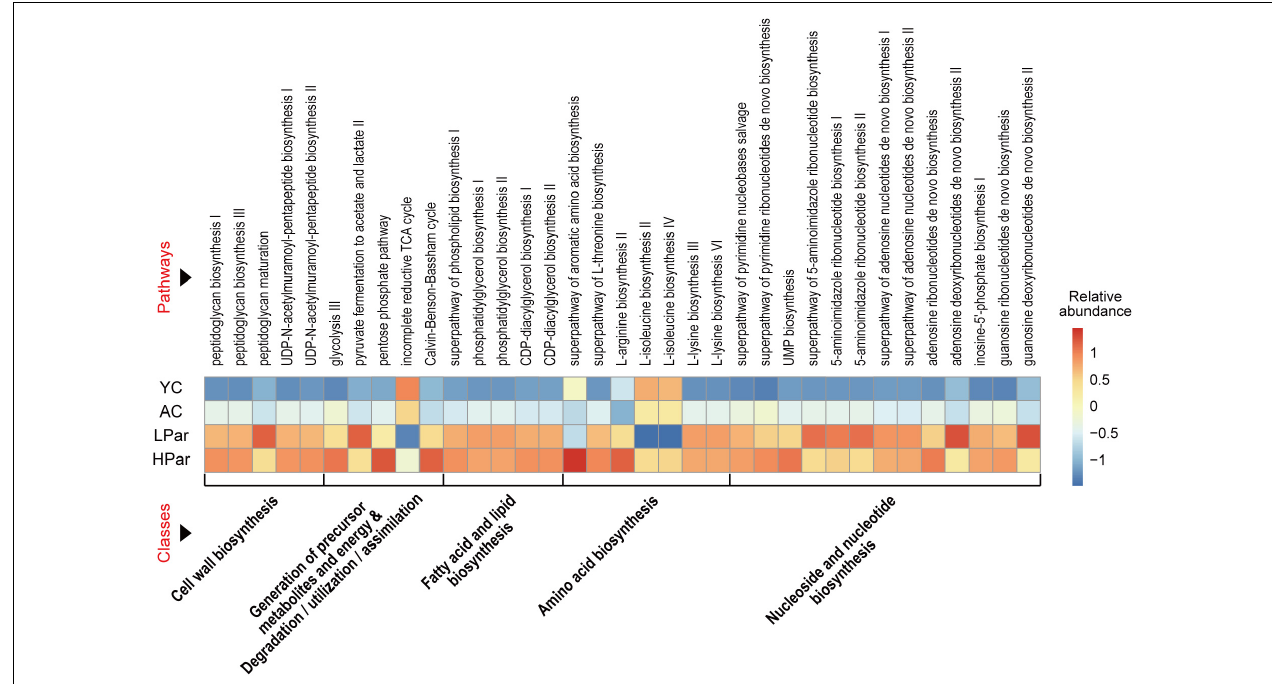
FIGURE 3 | Pathway enrichment of differential gut microbial genes between the YC, AC, LPar and HPar groups based on function prediction using Picrust 2 ( P < 0.05).